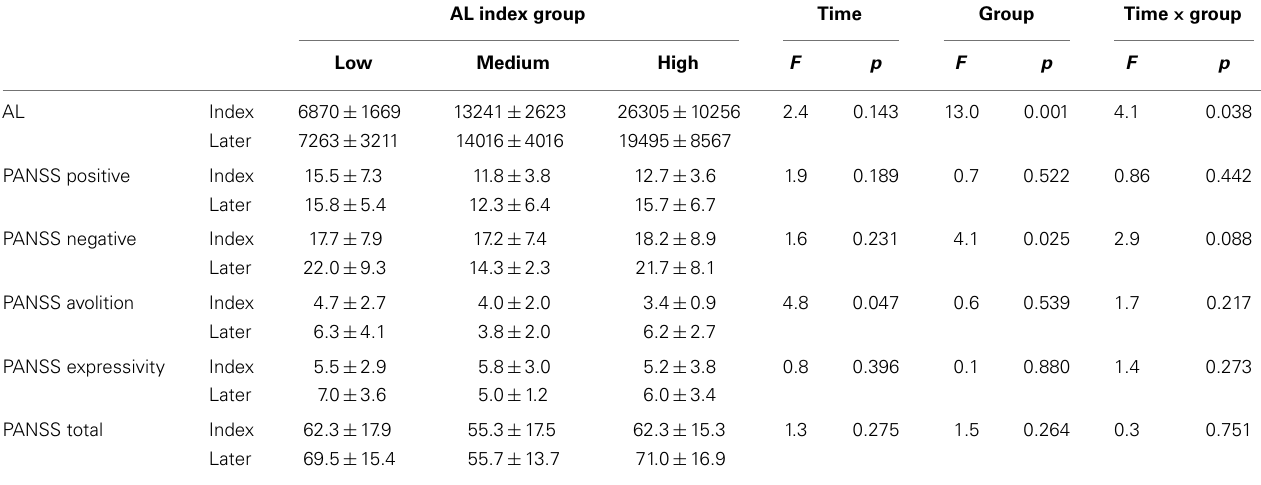
Table 4 | Repeated measuresANOVA between episodes ( n = 18)